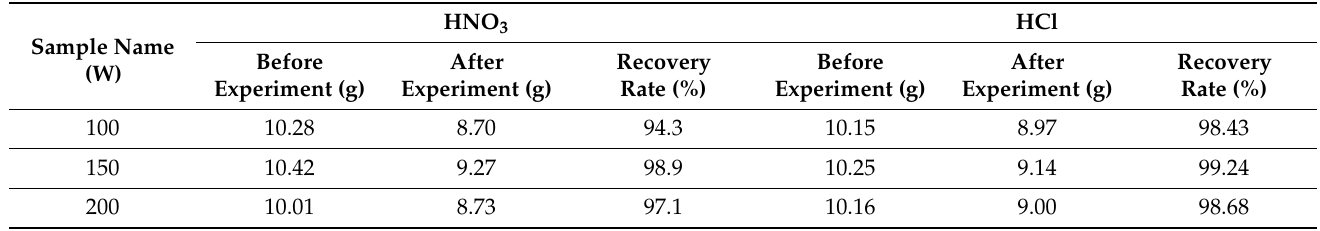
Table 12. Change in the photovoltaic cell weight before and after experiment and the Si recovery rate—ultrasonic